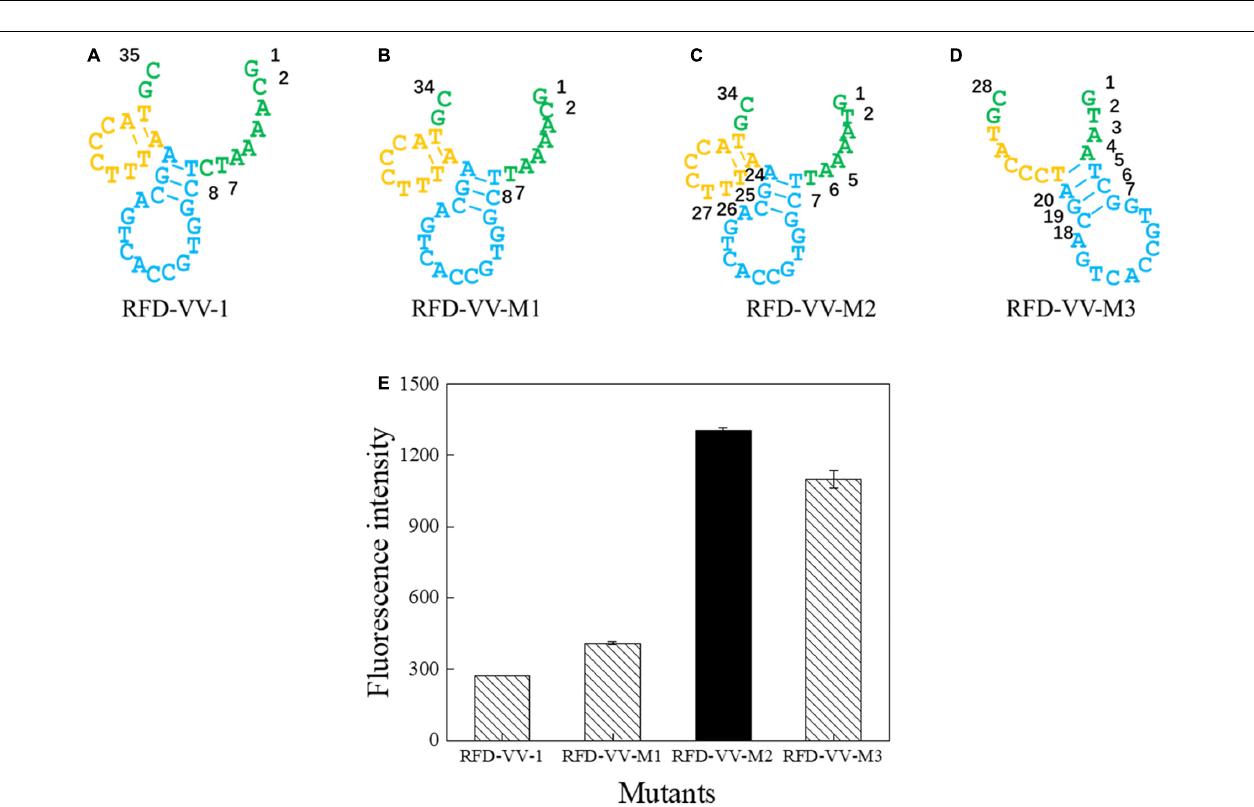
FIGURE 4 | Catalytic core sequences of (A) RFD-VV-1, (B) RFD-VV-M1, (C) RFD-VV-M2, and (D) RFD-VV-M3. (E) Activity of mutant DNAzymes. The error bars represent the mean and standard error of three repeats.